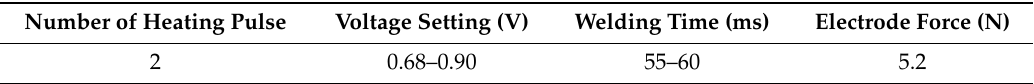
Figure 2. Curves of voltage, current and dynamic resistance collected in a welding process.